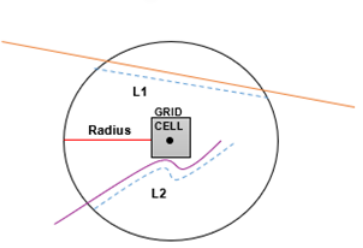
Figure 2. Procedure to calculate fracture density Land coverage: To obtain coverage types, Landsat 8